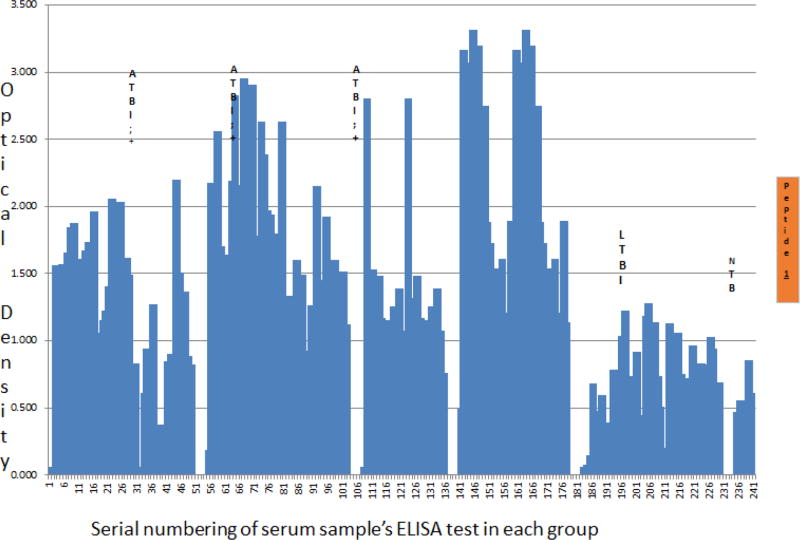
Host TMKmt specific IgG levels detected by UG-peptide 1 based EIAs among sera of HIV+ and HIV −ve participants with ATB, LTBI, and NTB. This figures shows levels of anti-TMKmt specific IgG responses detected by UG-peptide 1 based EIAs among 214 serum samples stratified as either HIV +ve (122) or HIV−ve (37) ATB versus LTBI (47) and No TB (8). Host TMKmt specific IgG levels detected by UG-Peptide 1 EIA capable of differentiating ATB from LTBI (ATBI=OD>1.00 vs. LTBI=OD<1.00); unlike peptide 2. HIV −ve persons display better anti-TMKmt IgG responses (ODs>1.500) relative to HIV +ve (ODs<1.500). This data is consistent with Ag capture results that reveal better M. tuberculosis control among HIV −ve persons relative to HIV +ve. The notable low levels of anti-TMKmt specific IgG Ab responses among PLWHA relative to their HIV −ve counter-parts tallies with the immunodeficiency seen in the former group. This makes UG-peptide 1 and its derivative PAb-0655 potential correlates of immune function among PLWHA.